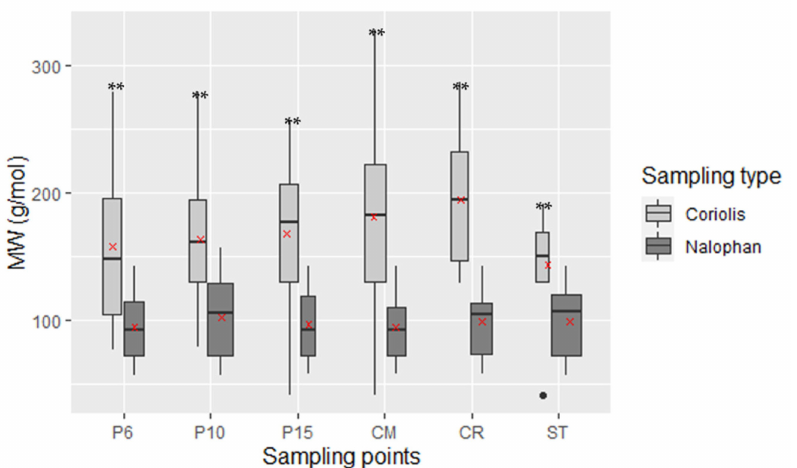
Figure 2. Comparison of molecular weights according to the sampler type used. The red crosses repre- sent the mean values. MW are significantly different between two techniques (** mean p value < 0.01) values follow normal distribution except ST values. Black dott represents an outlier value of the